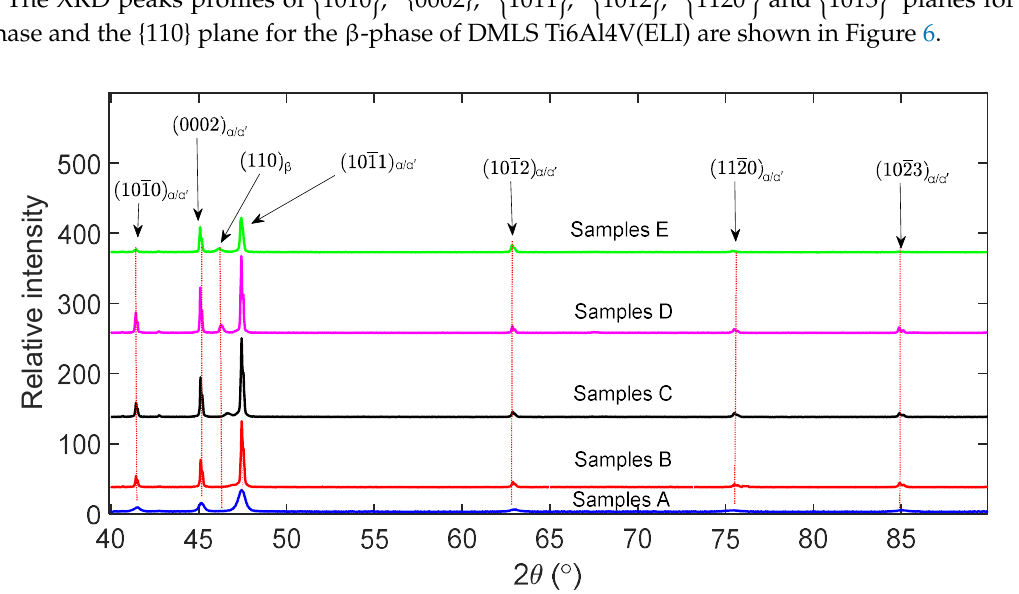
Figure 6. The X-ray diffraction patterns of the as-built (samples A), as-built and stress relieved (samples B), and as-built, stress relieved and annealed samples (samples C, D and E) of DMLS Ti6Al4V (ELI).